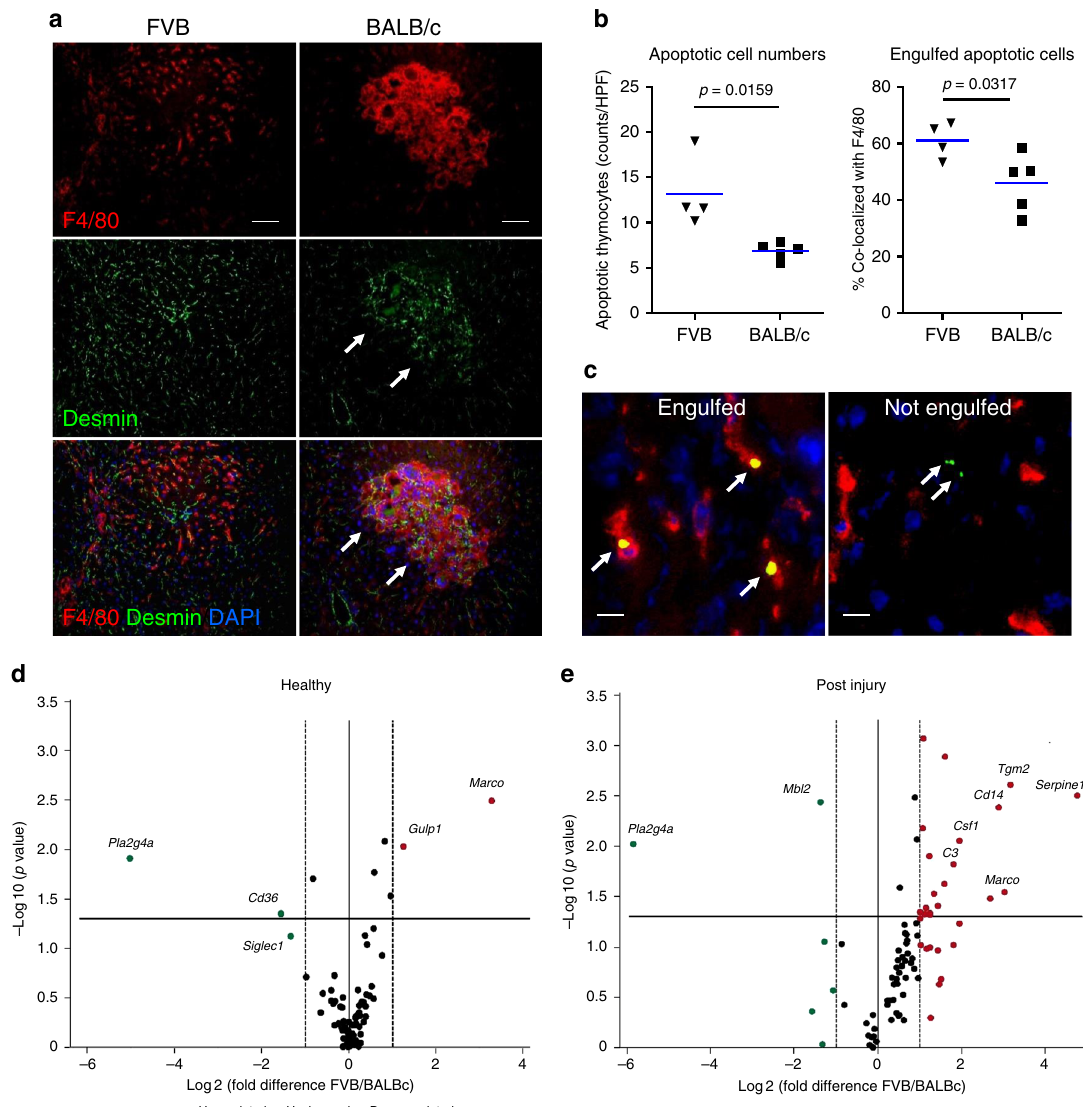
Fig. 3 Impaired phagocytic macrophage function and efferocytosis after liver injury in fi brosis-susceptible BALB/c strain. a Double immuno fl uorescence staining for the HSC marker desmin (green) and macrophage cell marker F4/80 (red) in FVB (left column) and BALB/c mice (right column) in late stage (8 days) of recovery. Normal peri-sinusoidal localization of desmin-positive stellate cells and F4/80-positive macrophages is restored in FVB mice, but not in BALB/c mice. Note large clusters of desmin-positive stellate cells (arrow) accumulate within granuloma-like macrophage in fi ltrates persisting in pericentral areas of BALB/c livers. Representative images at original magni fi cation (×200; bar, 50 μ m). b Total apoptotic cell counts (left panel) and % of apoptotic thymocytes engulfed by hepatic F4/80 + macrophages (right panel) signi fi cantly increased in the livers of FVB versus BALB/c mice 48 h post- TAA-induced liver injury. In vivo apoptotic thymocytes phagocytosis assay was performed as described in “ Methods ” and analyzed by cell scoring/ counting in 10 random HPF per mouse. n = 4 (FVB), n = 5 (BALB/c); p value as indicated (two-tailed, Mann – Whitney t test). c Representative images of apoptotic cells (green, arrows; bar, 10 μ m) scored as engulfed (left panel) or non-engulfed (right panel) by hepatic F4/80 + macrophages (red) 1 h after i.v. infusion of fl uorescently labeled apoptotic thymocytes (green). d , e Volcano plots comparing statistically signi fi cant phagocytosis-related gene expression changes between FVB and BALB/c strains in total RNA of naive ( d , healthy) or injured ( e , 48 h post-TAA) livers. Total of 84 phagocytosis genes analyzed via RT 2 PCR phagocytosis array; values are obtained from four biological replicates after normalization to housekeeping gene β 2MG . Log 2 values of the fold changes are plotted on the x -axis, the − log 10-transformed p values are plotted on the y -axis. The solid line in the graphs marks the p value of 0.05, and the dotted line marks a one-fold change. While only few genes were differentially expressed at baseline (C, two genes upregulated and two genes down- regulated), 20 genes were upregulated in response to injury in FVB mice compared to BALB/c ( p < 0.05, t test). Differentially regulated genes by mini- array are annotated, and subset of genes cross-validated by TaqMan RT-PCR method are shown in bold (see also Supplementary Tables 4 – 6 for complete list of genes and TaqMan RT-PCR validation data). Source data are provided as a Source Data fi